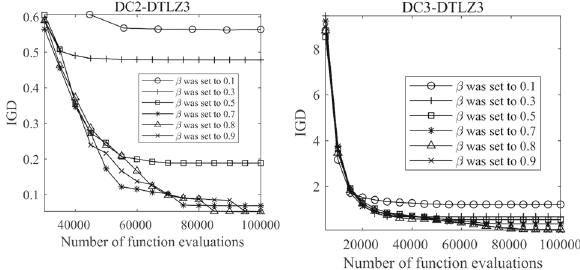
Fig. 8 Convergence profiles of IGD values obtained by the proposed EGDCMO corresponding to different values of β , averaged over 30 runs